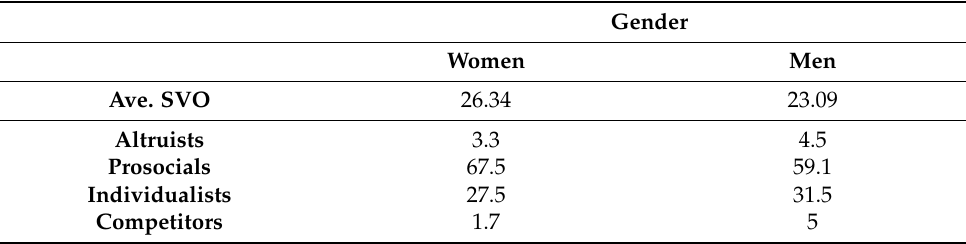
Table 1. Average Social Value Orientation (SVO) of women and men along with the percentage of altruists, prosoicals, individualists, and competitors based on their primary social value